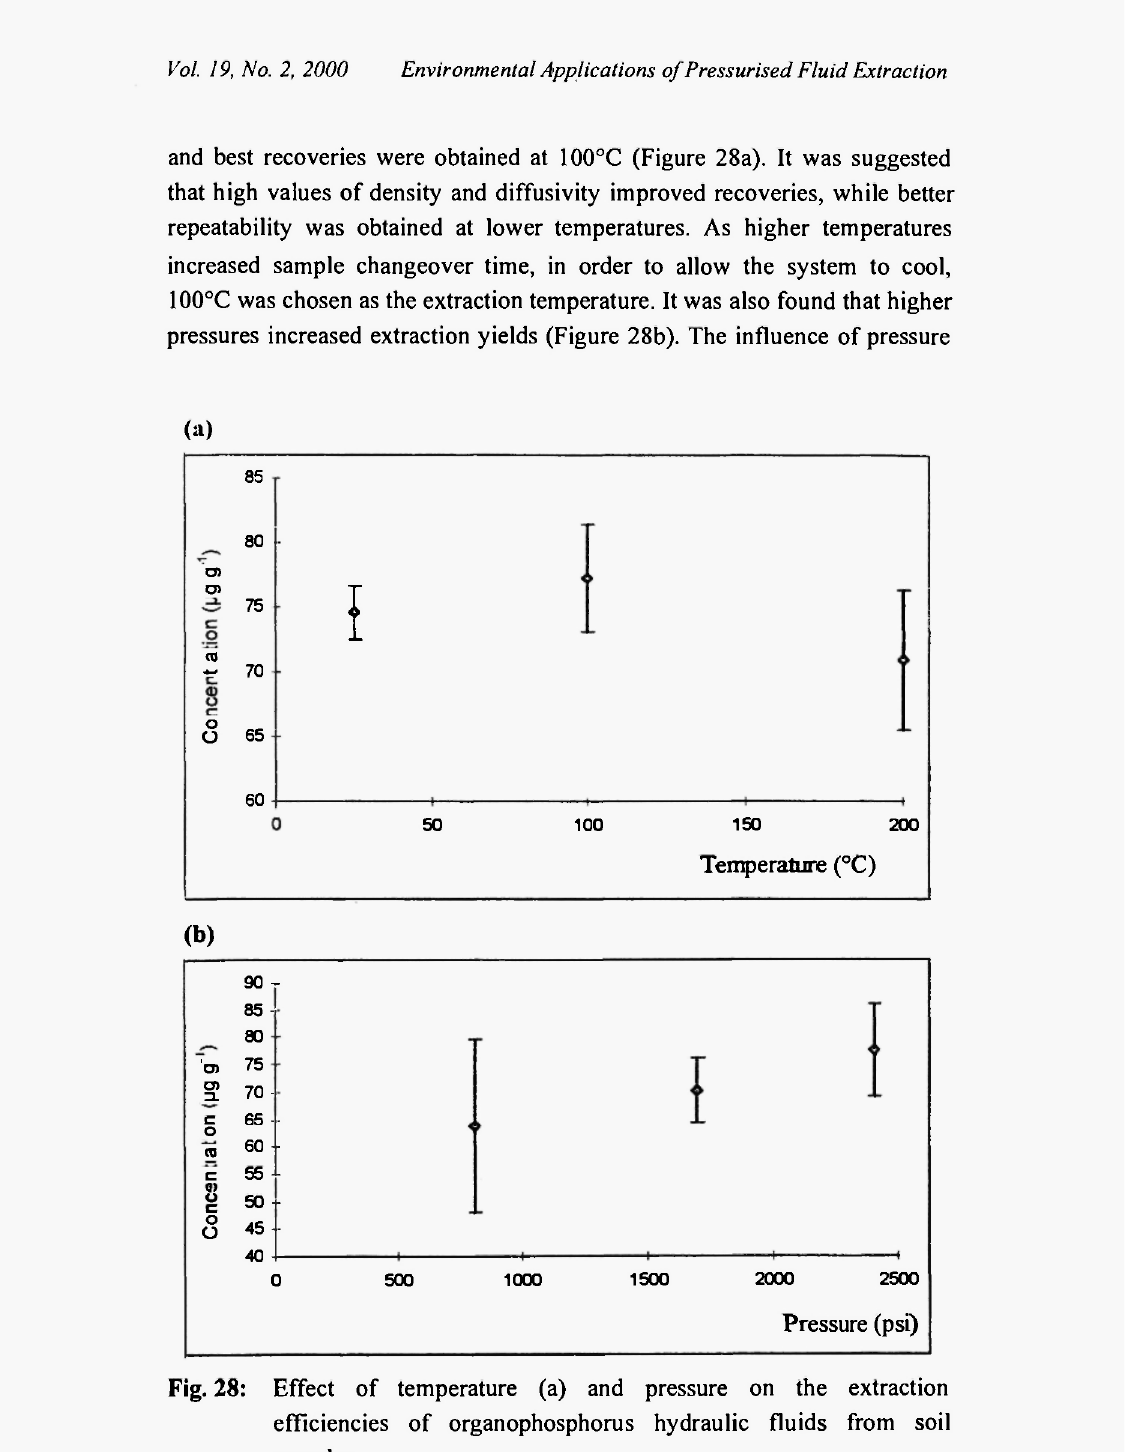
Fig. 28: Effect of temperature (a) and pressure on the extraction efficiencies of organophosphorus hydraulic fluids from soil